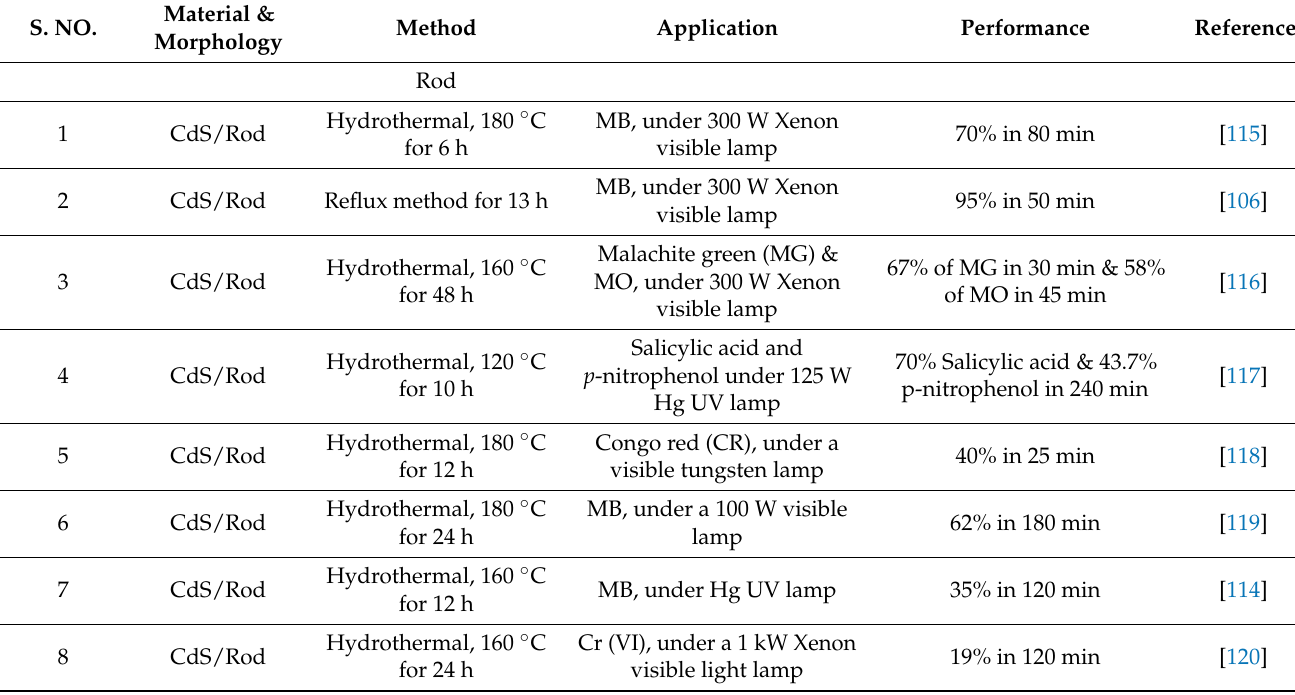
Table 3. Details of the synthesis and photocatalytic performance of various morphologies of CdS. S.